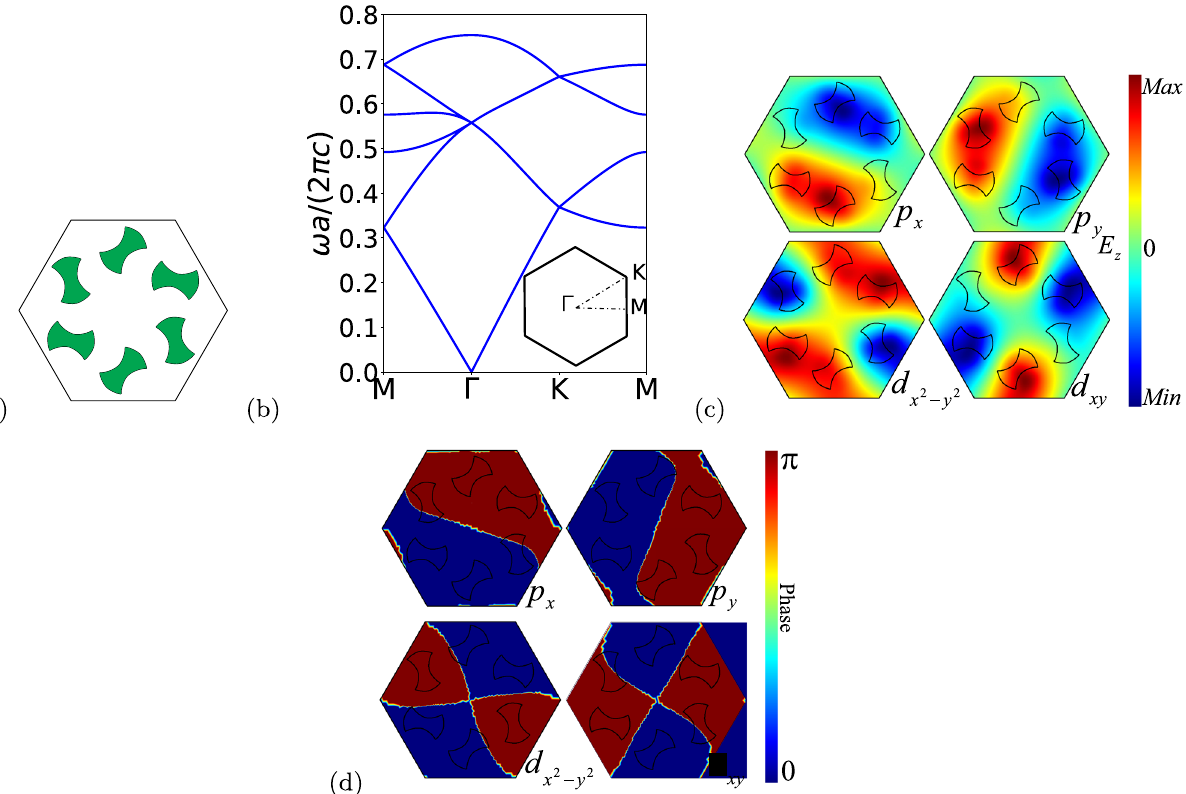
Figure 2. Results for the unperturbed photonic crystal. ( a ) Scheme of the unit cell with angular perturbation 0 . ( b ) Band structure for the TM modes with ε φ = ( c ) Profile of the electric field E z at the Dirac point. We can see that pseudospin states are dipole modes (upper panels) and quadrupole modes (lower panels). ( d ) Phase of the electric field E z at the Dirac point. We can see that pseudospin states are dipole modes (upper panels) and quadrupole modes (lower panels). (We used COMSOL Multiphysics v.6.0. www. comsol. com. sofware to create the